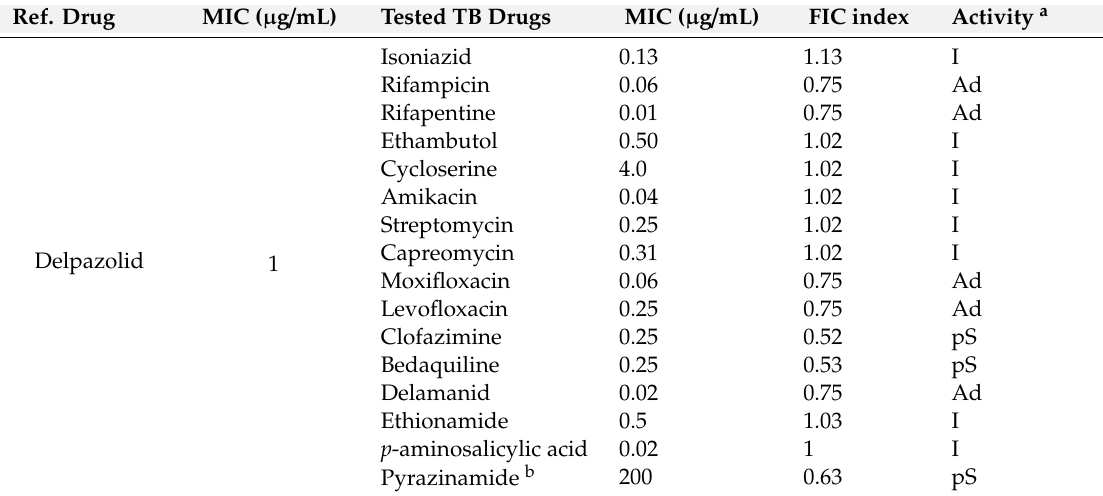
Table 6. MICs of selected anti-tuberculosis compounds against M. tuberculosis H37Rv and corresponding interaction profiles with delpazolid assessed by